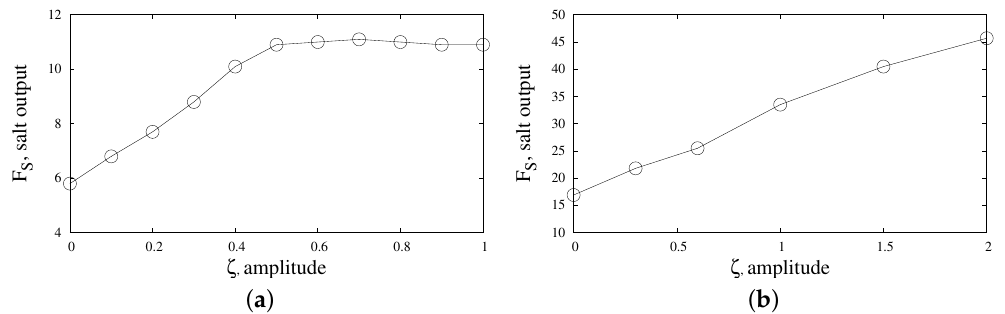
Figure 4. The average flow of the reaction product at the outlet of the continuous-flow reactor as a function of the amplitude ζ : ( a ) large Hele-Shaw (HS) unit (100 × 100); ( b ) small HS unit (20 × 20). H 0 = 1, Q =